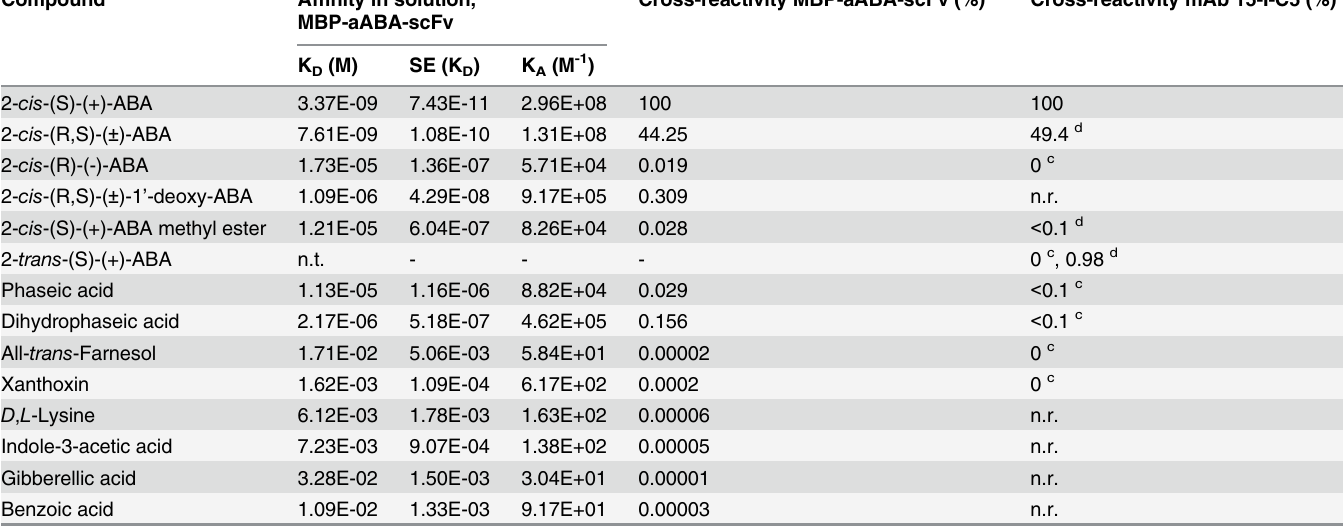
Table 3. Selectivity of